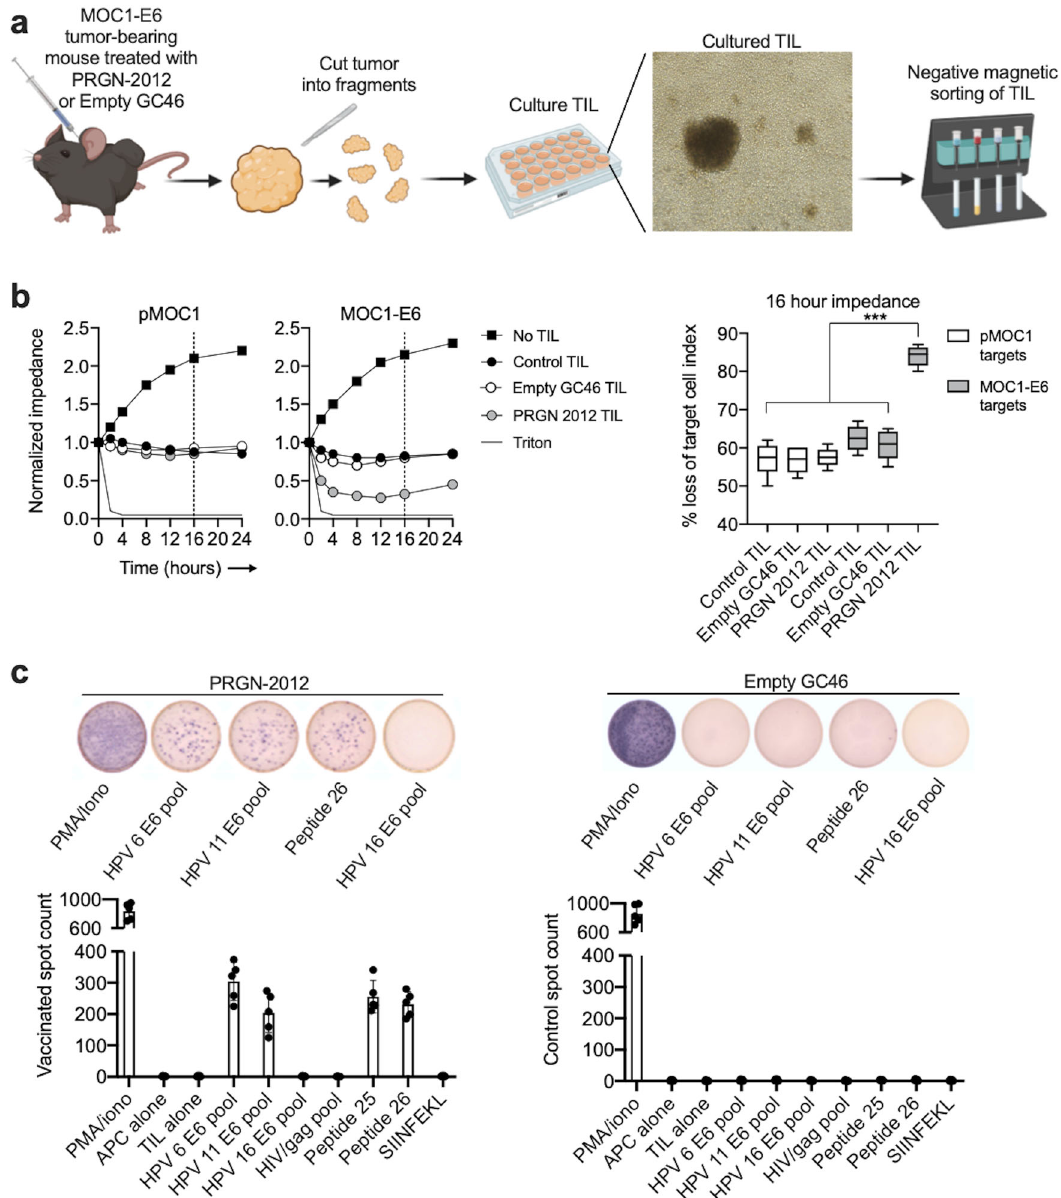
Fig. 6 HPV antigen-speci fi c effector T lymphocytes in fi ltrated tumors following PRGN-2012 treatment. a Schematic of TIL cultured from tumors from MOC1-E6 tumor-bearing mice treated with PRGN-2012 or empty GC46 vector ( n = 5 mice/group). b Representative impedance analysis of cultured TIL from MOC1-E6 tumors treated with PRGN-2012, empty GC46, or control (PBS), then cocultured with either parental MOC1 or MOC1-E6 target tumor cells ( n = 5 tumors per condition). TIL are added to target cells at experimental time 0. Percent killing (represented as % loss of target cell index) is quanti fi ed 16 h after the addition of TIL to targets and is shown on the right. c Photomicrographs of representative ELISpot wells and quanti fi cation of IFN γ spots demonstrating responses to HPV6 and 11 overlapping 15-mer peptide pools as well as synthesized minimal peptides in TIL cultures from MOC1-E6 tumors treated with PRGN-2012 or empty GC46. TIL tumor-in fi ltrating lymphocytes. *** p < 0.001;